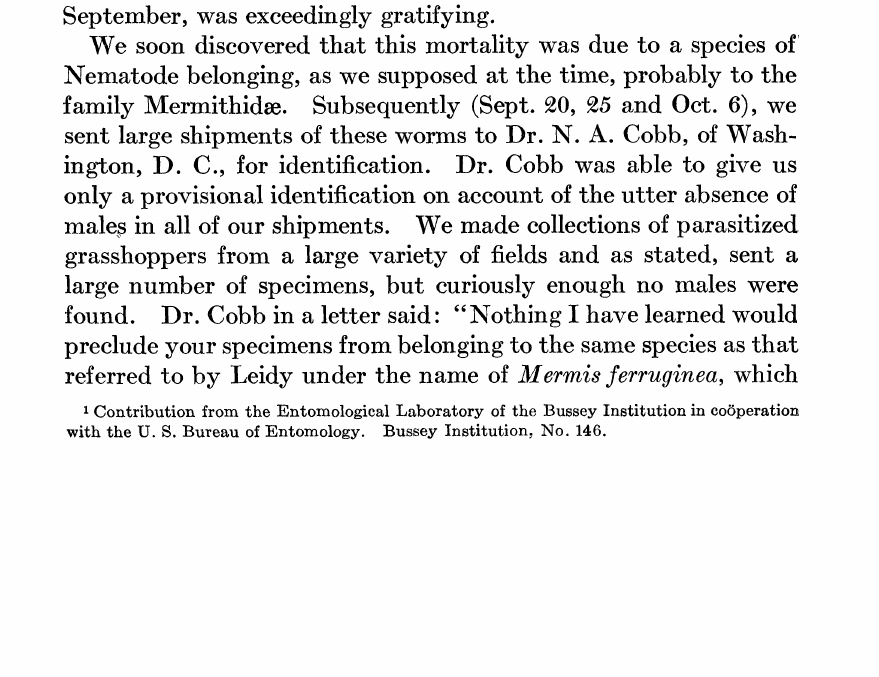
EXPLANATION OF PLATE I. . Terga and wing bases of a Plecopteron. Terga and wing bases of the Coleopteron Photuris. Fig. Fig. 3. Terga and wing bases of Embia major. Fig. 4. Terga and wing bases of the Dermapteron Echinosoma.. ON THE OCCURRENCE OF A MERMIS EPIDEMIC AMONGST GRASSHOPPERS? BY R. W. GLASER and A. M. WILCOX.